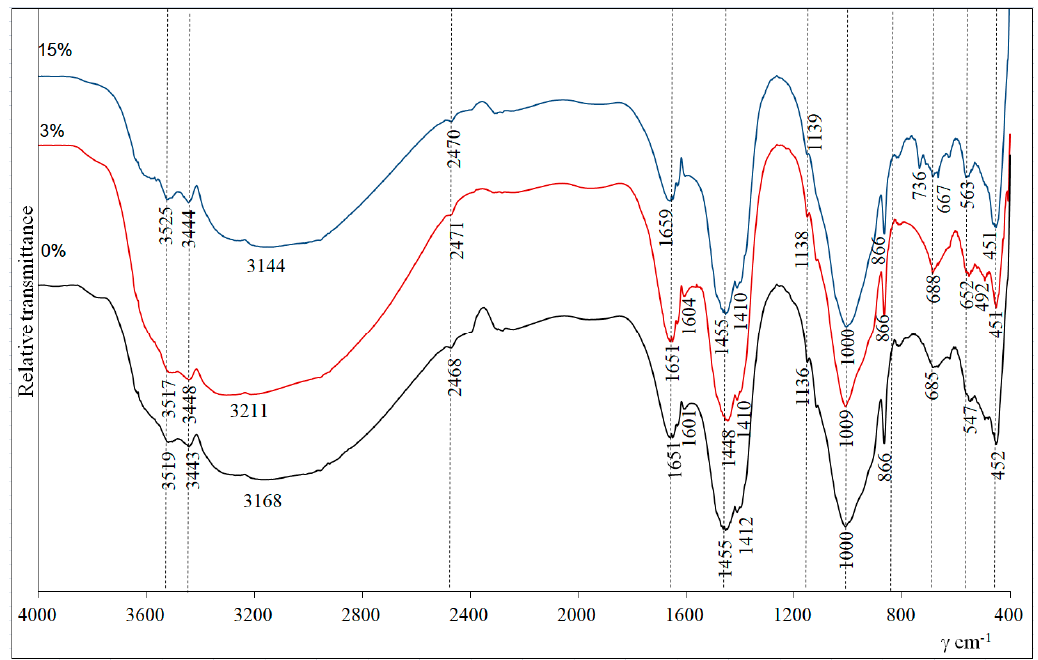
Figure 4. Fourier-transform infrared FTIR analysis of alkali-activated biomass bottom ash without zeolitic waste (0%) and with (3% and 15%) zeolitic waste.